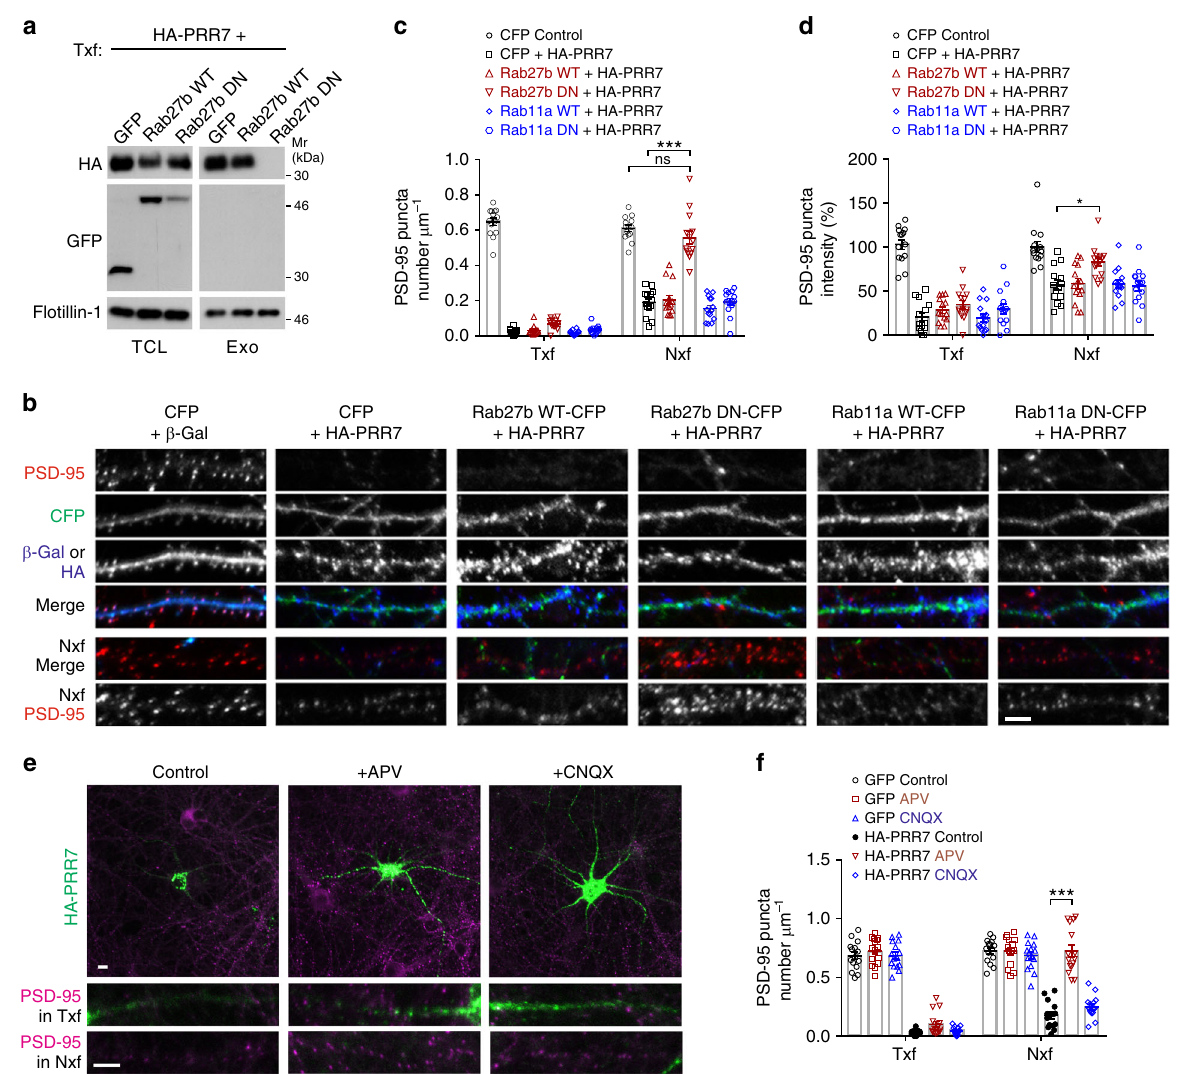
Fig. 6 Exosomal secretion of PRR7 is required for the elimination of excitatory synapses in neighboring neurons. a Blockade of exosomal secretion of HA- PRR7 by Rab27b DN. b – d Effect of Rab11a and Rab27 WT and DN on the PRR7-induced loss of PSD-95 clusters. Representative immuno fl uorescent images of PSD-95 in hippocampal neurons transfected with the constructs indicated above images ( b ). Quantitation of the data on PSD-95 cluster density ( c ) and intensity ( d ). n = 14 per condition. e , f Effect of APV and CNQX on the PRR7-induced loss of PSD-95 clusters. Representative immuno fl uorescent images of PSD-95 ( e ) and quantitation of the data ( f ). n = 15 each. Scale bars, 5 μ m. Two-way ANOVA, post hoc Tukey ’ s test: F 5,156 = 278.4 ( c ), F 5,156 = 45.49 ( d ), F = 199.7 ( f ). *** P < 0.0001 and * P = 0.0197. Data are mean ± SEM. Mr relative molecular 5,168